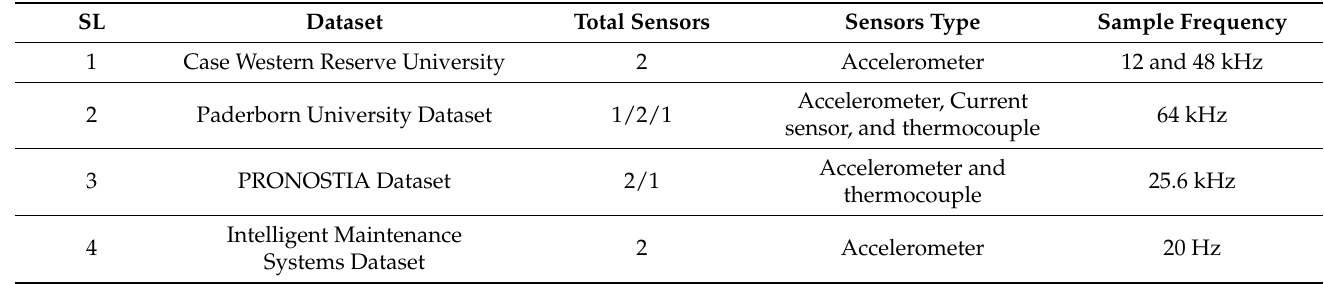
Table 1 provides a summary of different bearing datasets mentioned above. Table 1. Comparison of motor bearing datasets.